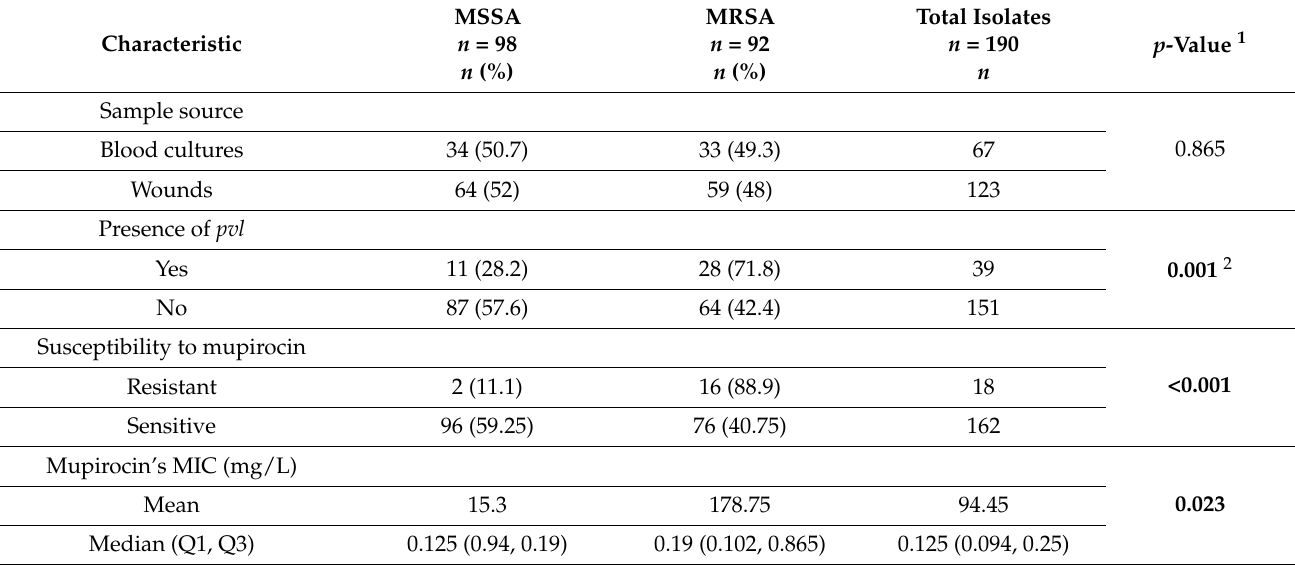
Table 1. Characteristics of clinical